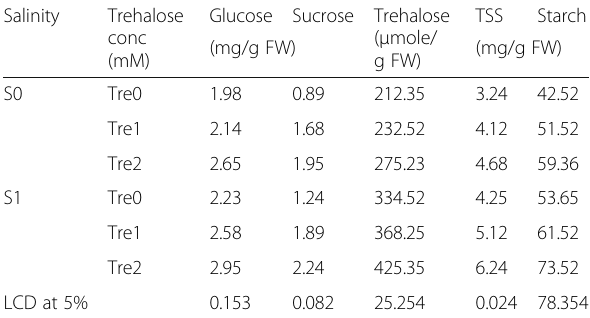
Table 5 Effect of trehalose at 0 mM (Tre 0), 10 mM (Tre 1), and 50 mM (Tre 2) on carbohydrate constituents of wheat plants irrigated with tap water (S0) or diluted sea water at 6.25 dS/m (S1). Results are means of two successive seasons Salinity